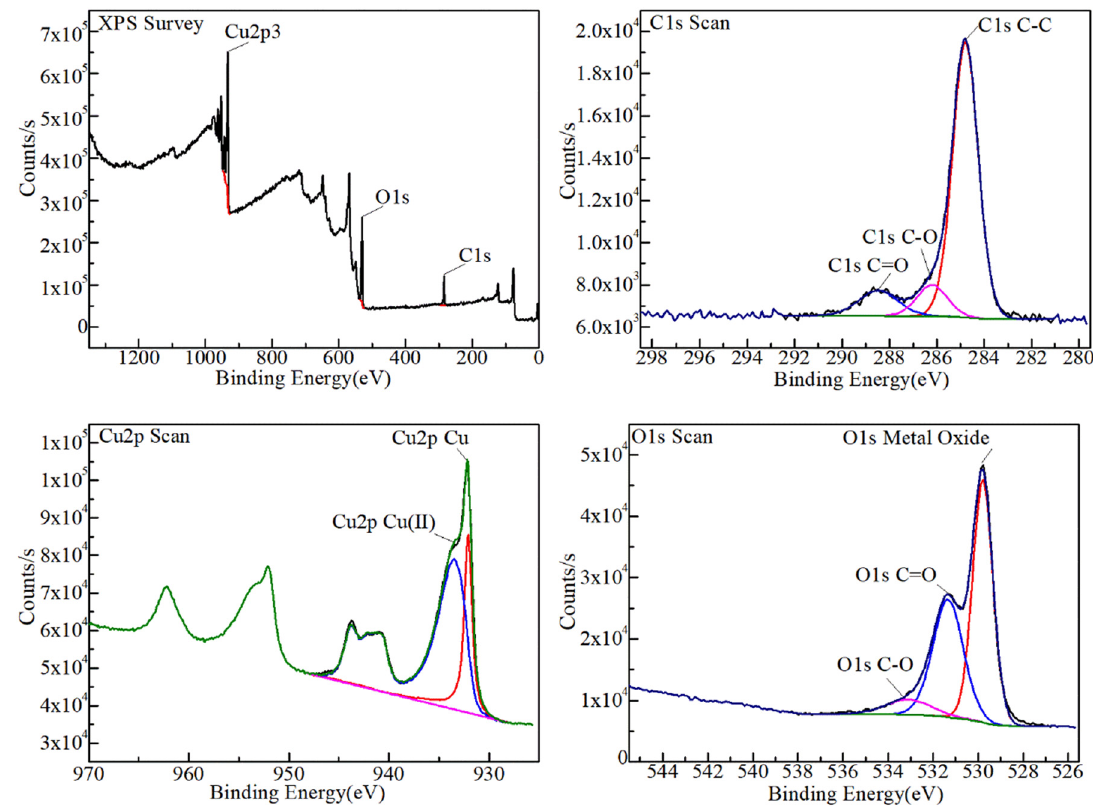
Figure 7: Results from XPS analysis of the oxide layer that peeled o ff during